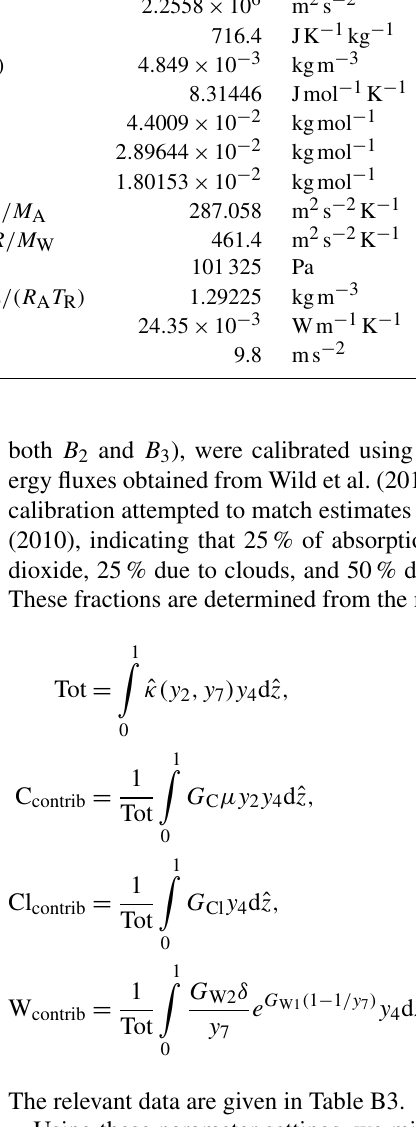
Using these parameter settings, we minimized the sum of squares of the differences between the data from Table B3 (after nondimensionalization) with the model outputs allow- ing the parameters k S , k C , k W , k Cl , b , and C D to vary. In the minimization calculation, the terms associated with the con- tribution values (last three columns of Table B3) were given a heuristic weight of 0.01, since these values are less reliable than the other data. The resulting calibrated values for these parameters are given in Table B2; the results of the fitting are given in Table B3 and Fig. B1. As can be seen in Ta- ble B3, the minimization achieved very good agreement with the globally averaged